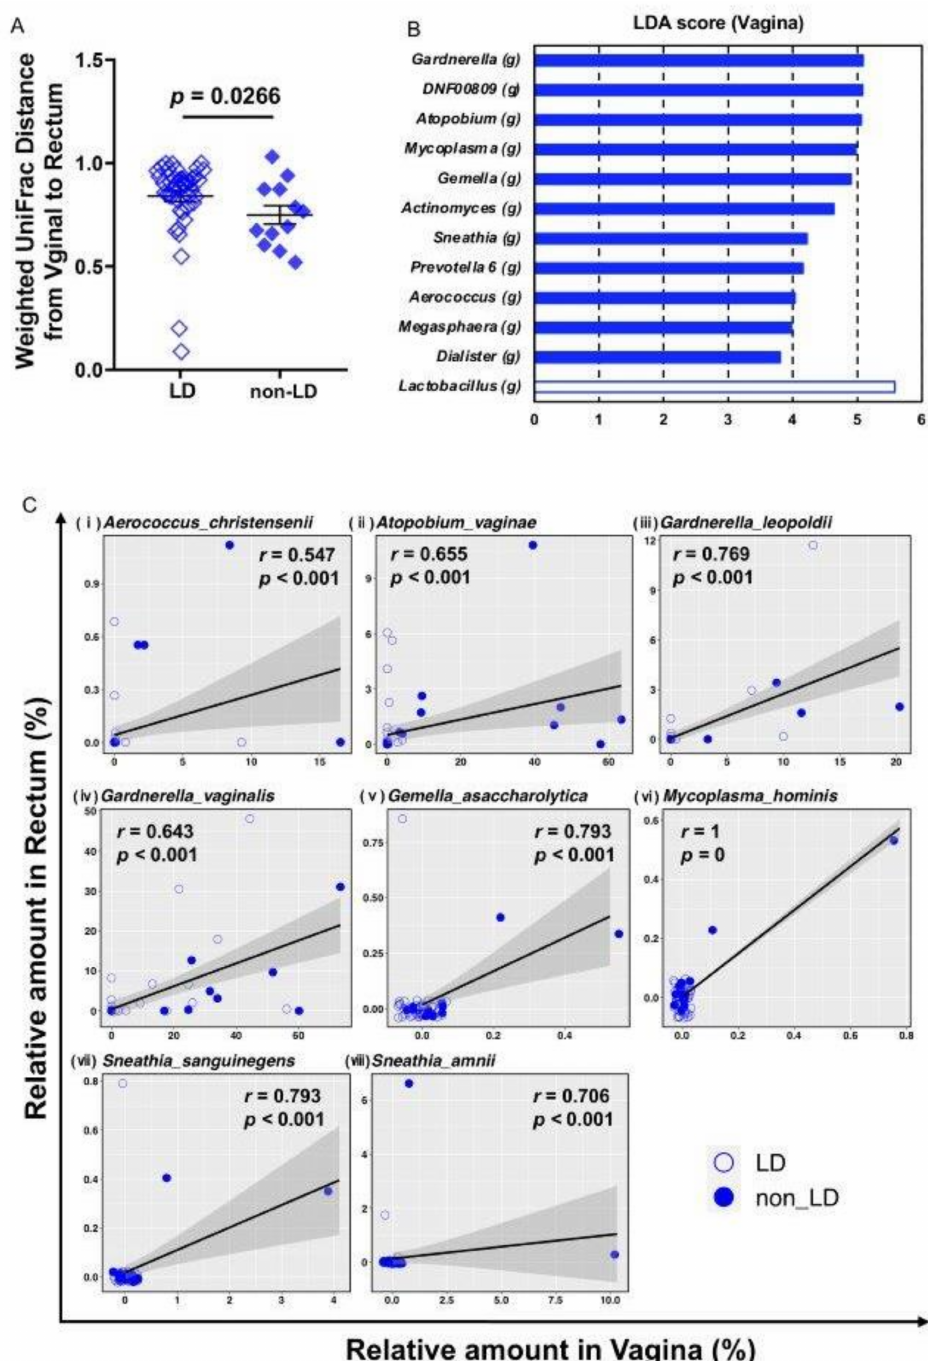
Figure 3. The microbial profiles of the paired vaginal and rectal samples from the same patients revealed the co-residence of specific bacterial species. ( A ) Weighted UniFrac Distance from Vagina to Rectum, data show the mean ± SEM and Mann Whitney U test was applied. ( B ) Differences in vaginal microbiota composition at the genus level were determined using the linear discriminant analysis (LDA) effect size (LEfSe) analysis (LDA score > 2). The bar graph shows the significantly different genera in the non-LD and LD group. ( C ) The correlation of their amount in vagina and rectum was examined for each species using Spearman correlation coefficient. The correlation coefficient and p- values are as shown in the graph. The raw data are available in Table